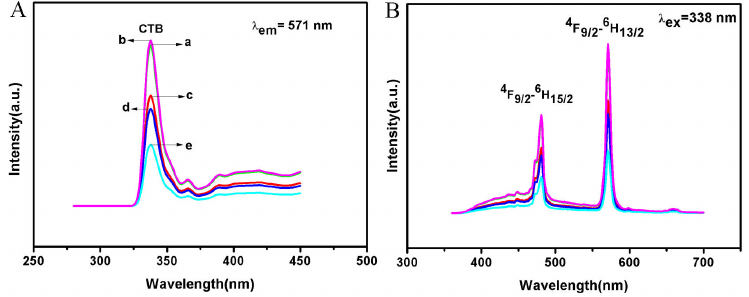
Figure 4. Excitation spectra ( A ) and emission spectra ( B ) of Fe 3 O 4 @SiO 2 @GdVO 4 :Dy 3+ with different doped concentrations of Dy 3+ (a: 0.5%, b: 1%, c: 2%, d: 3% and e: 4%).